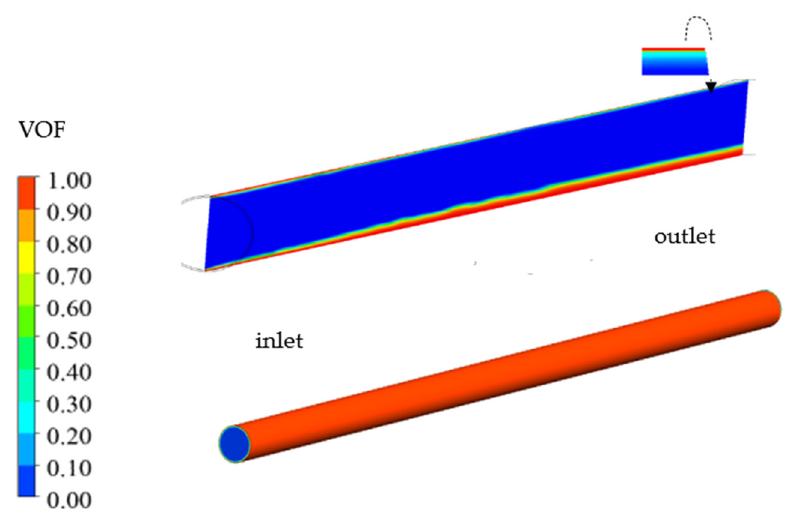
Figure 13. Contours of the liquid film distributions on the pipe walls represented by the water volume of fraction (VOF). Top-right : a vertical 2D mid-plane through the center of a horizontal pipe ( top-right ); Bottom-right : a full 3D liquid film distribution along the pipe wall.